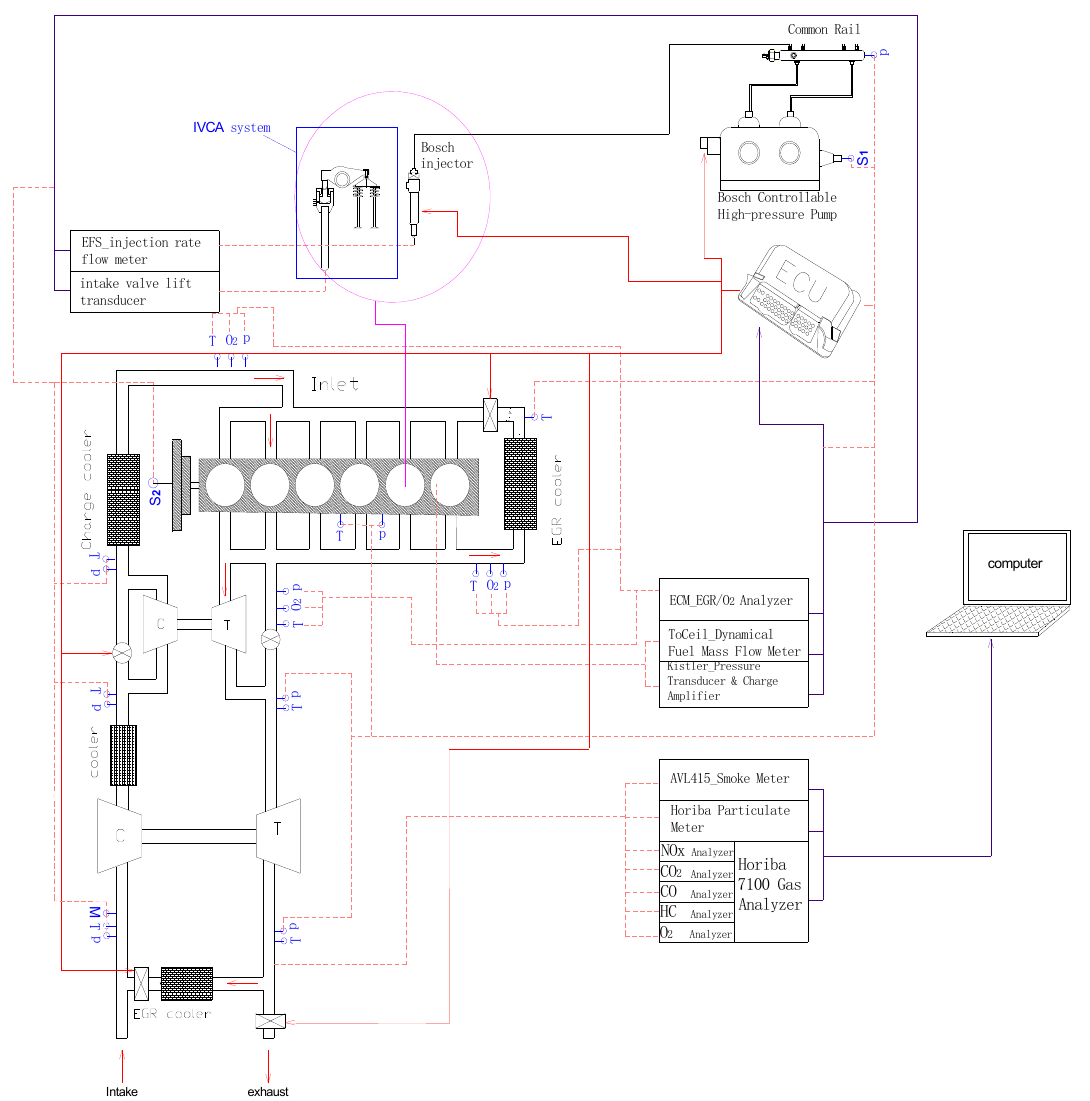
Figure 9. Schematic diagram of the test platform and test equipment. Note: P—pressure sensor, T—temperature sensor, M—intake flow sensor, S1—synchronization signal, S2—photoelectric encoder, O 2 —oxygen sensor.